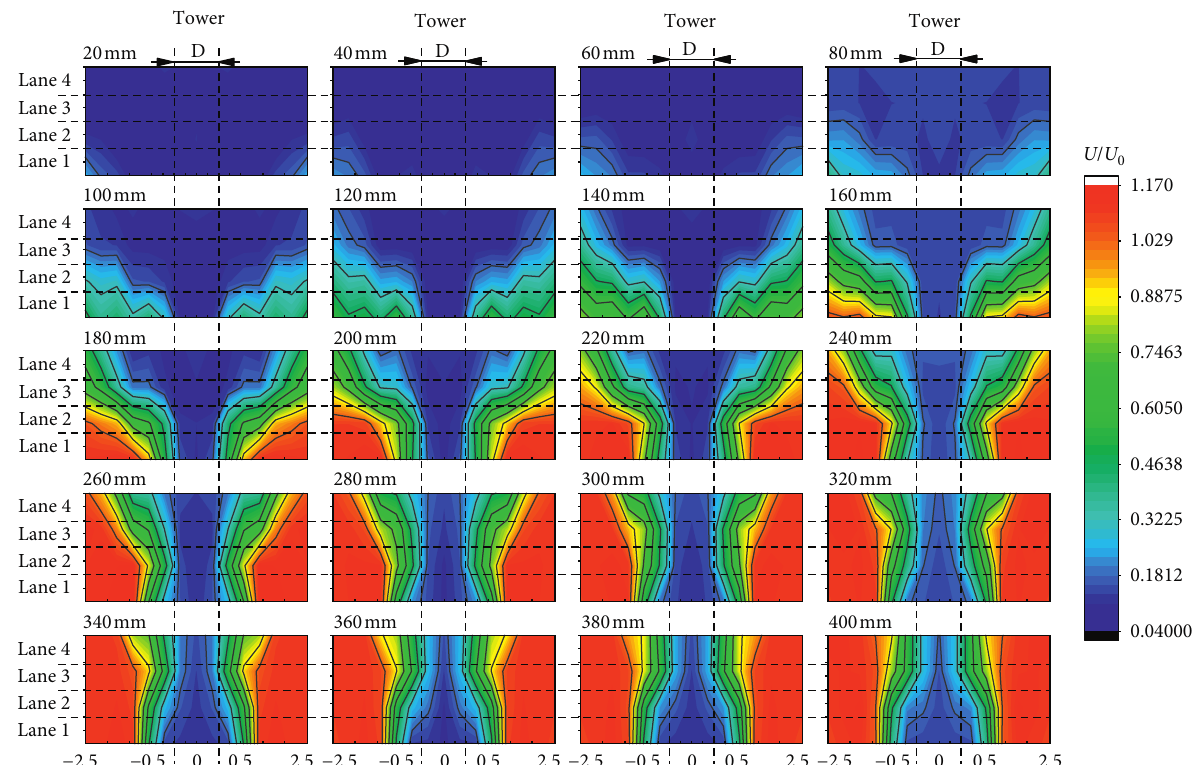
Figure 7: Contours of wind field on the bridge deck without wind